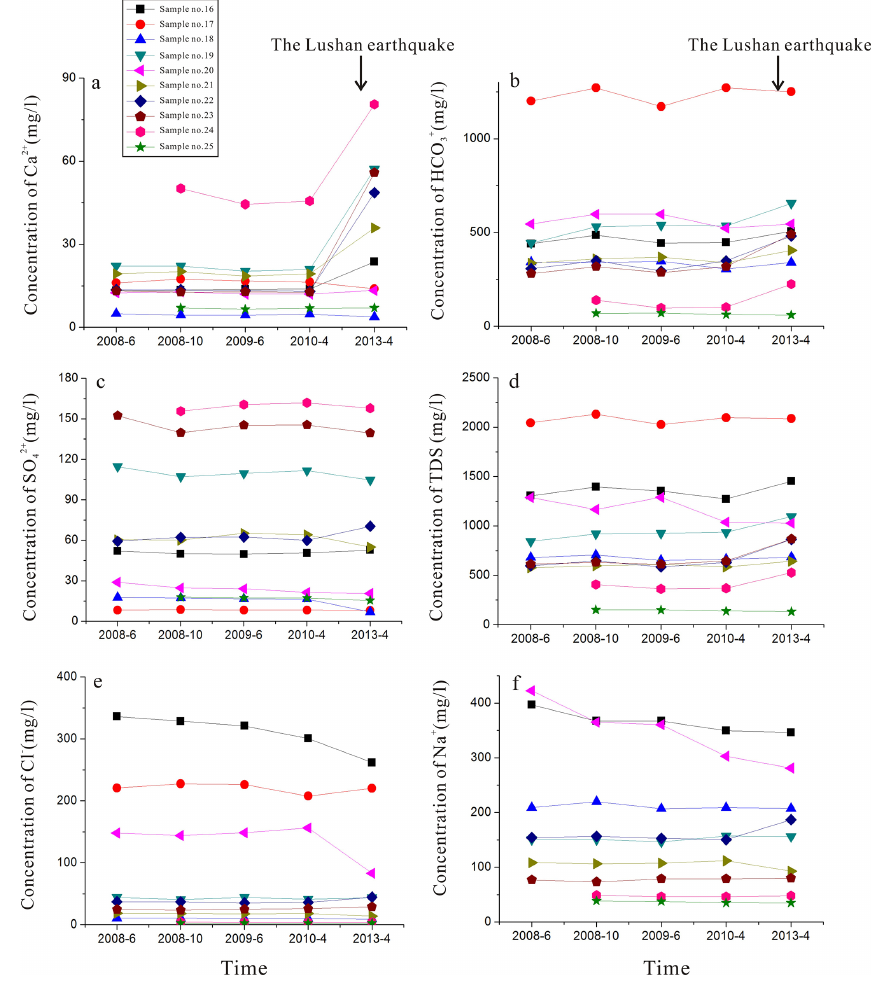
Figure 3. Temporal ion variations in the spring waters before and after the Lushan